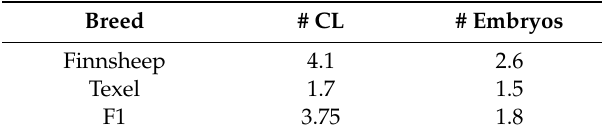
Table 1. Average number of corpus luteum (CL) and embryos in Finnsheep, Texel and their F1 crosses. The full details of the phenotypes are available in Supplementary Table